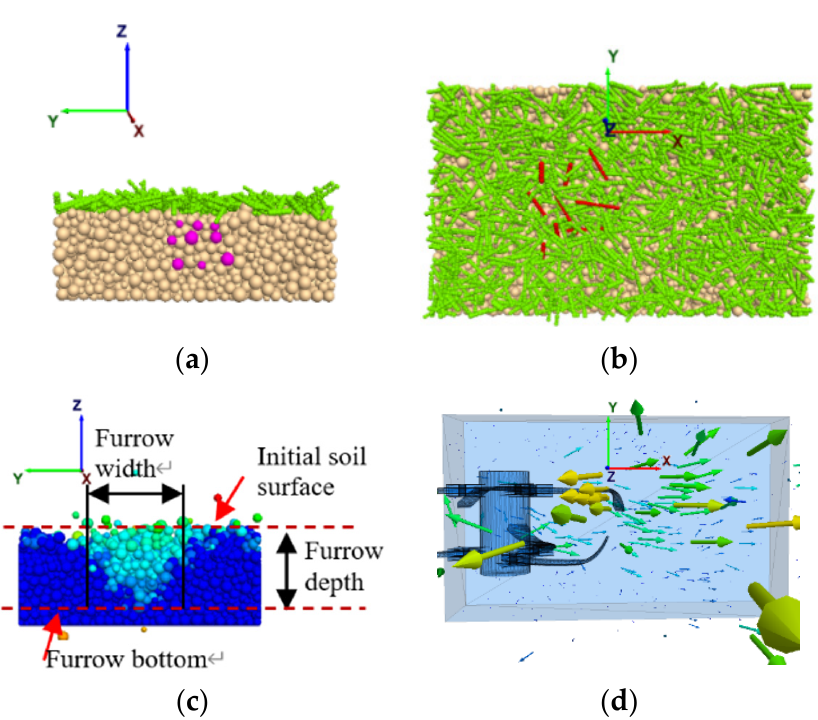
Figure 5. Monitoring soil and straw disturbance in the rotary tillage process (x,y,z reperesents the axes of the 3D DEM model). ( a ) Soil particles [60]; ( b ) Straw [60]; ( c ) Soil disturbance in DEM [60]; ( d ) Straw velocity vector map in DEM [137].